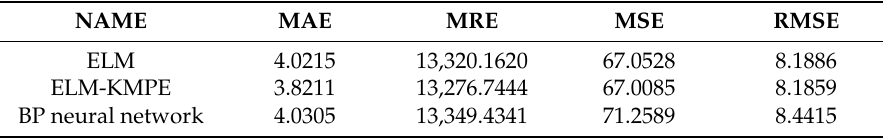
Table 5. Comparison of prediction errors of ELM, ELM- KMPE and BP under new